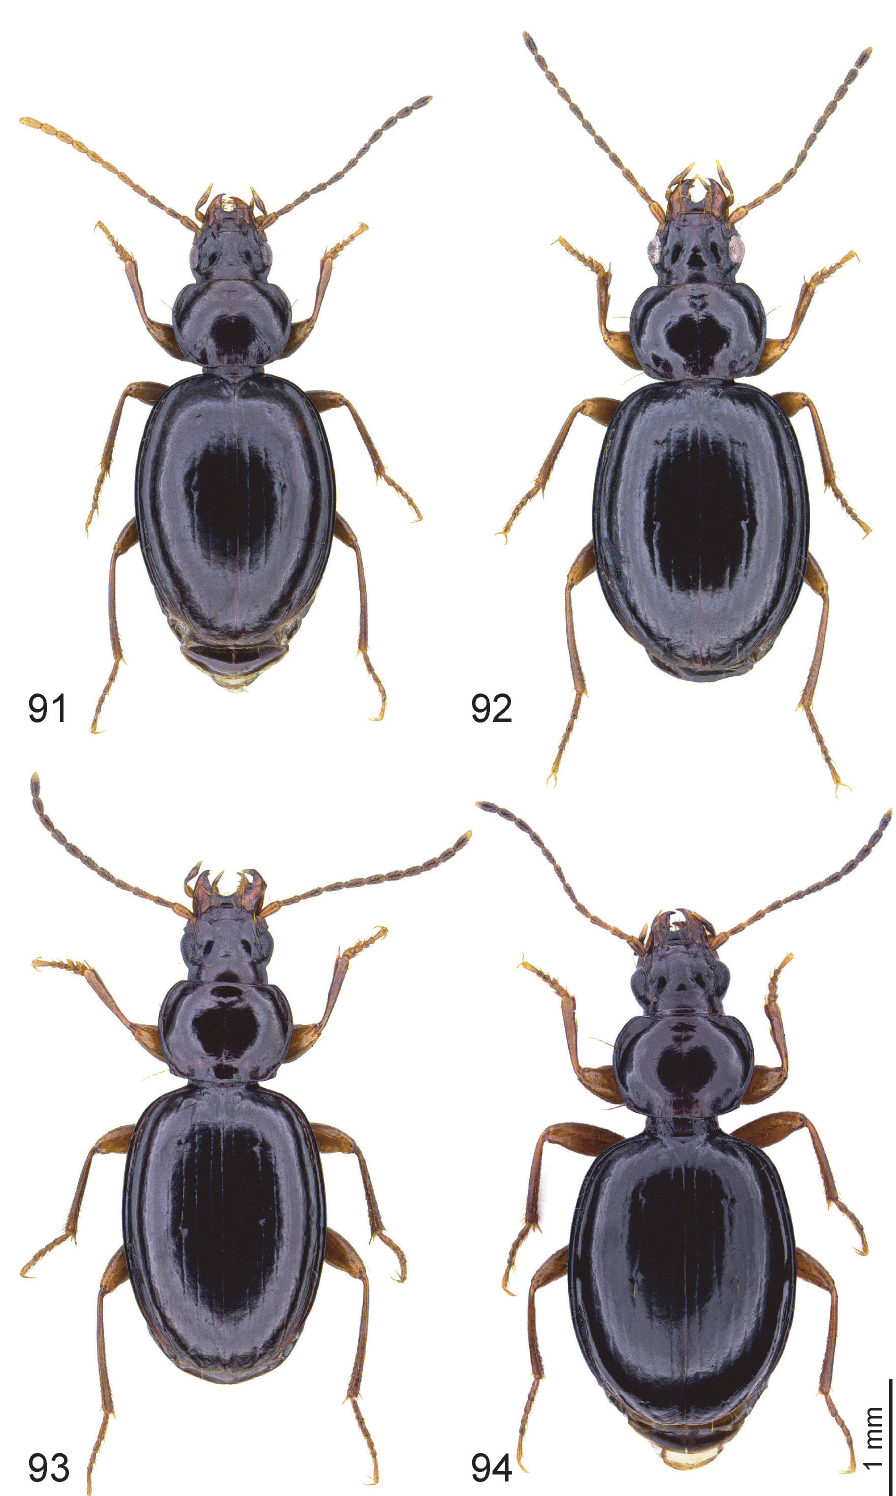
Figs 91–94. Trechus spp., habitus. 91 . T. fisehai sp. nov., paratype, ♂. 92 . T. angavoensis sp. nov., holotype. 93 . T. batuensis Magrini & Sciaky, 2006, ♂ from Sanetti Plateau near Tulo Dimptu. 94 . T. batuensis , ♂ from Tegona